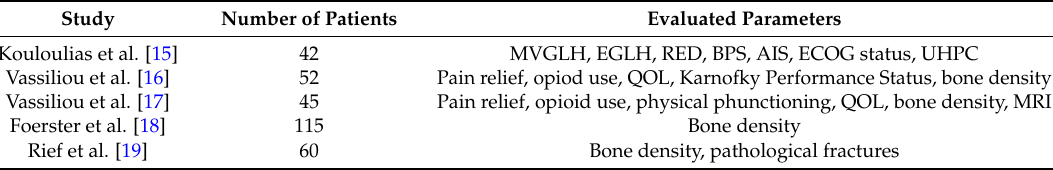
Table 1. Relevant studies with parameters related to bone mineral density for radiation therapy to bone